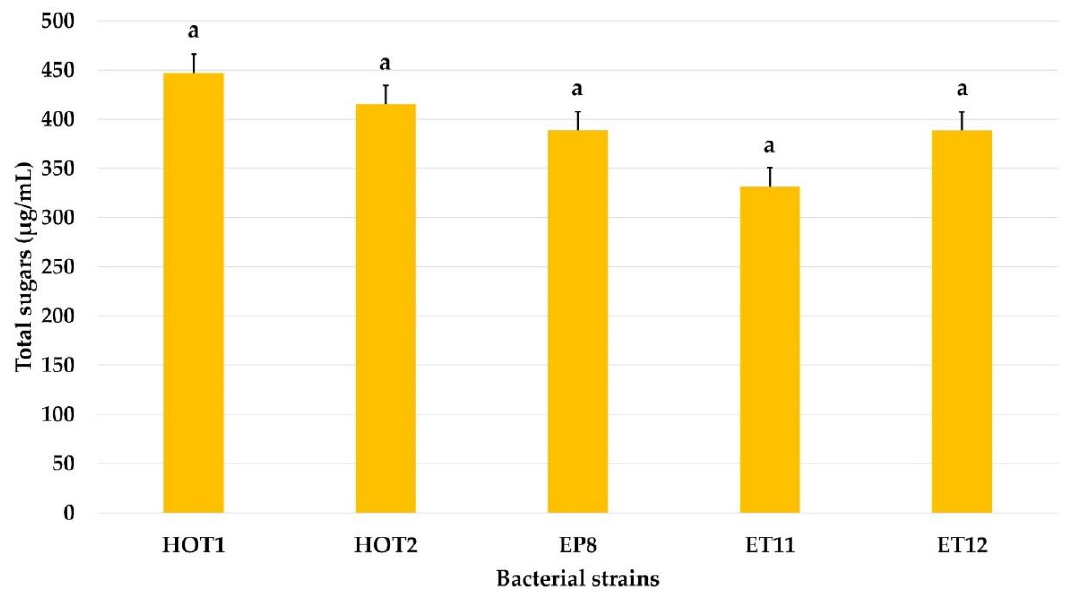
Figure 10. Estimation of the total sugars produced by the strains tested.